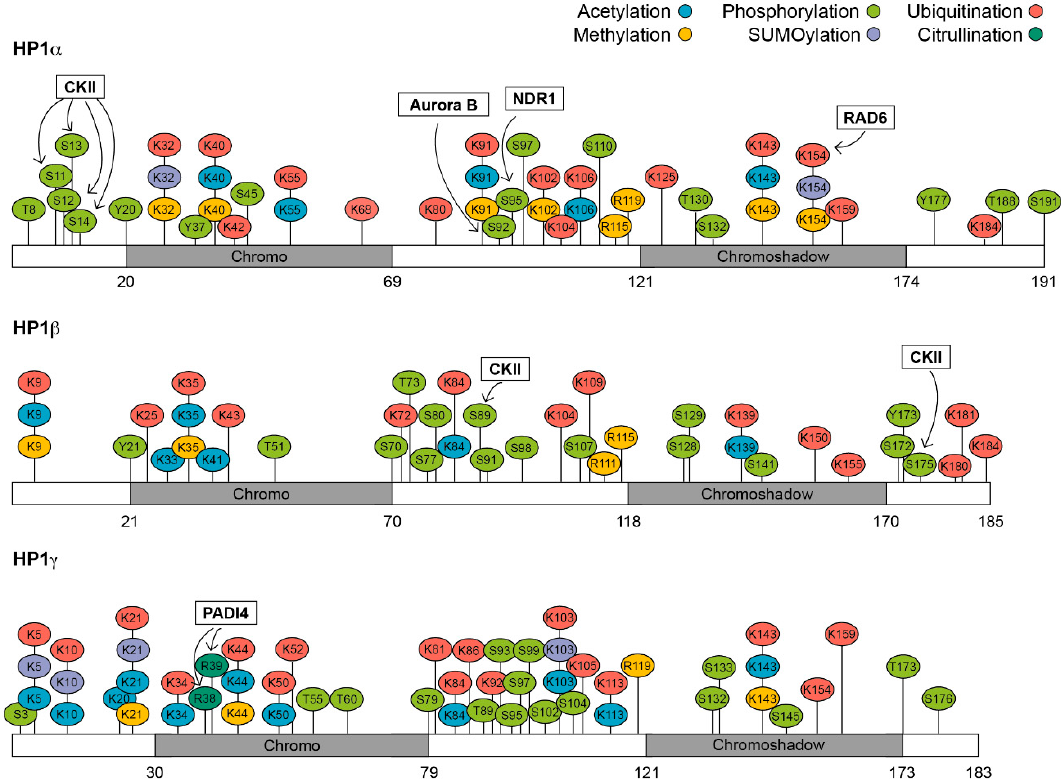
Figure 1. Heterochromatin Protein 1 (HP1) post-translational modifications. Acetylation (blue), methylation (yellow), phosphorylation (light green), SUMOylation (purple), ubiquitination (red) and citrullination (dark green) sites of HP1 α , HP1 β and HP1 γ are shown. Black boxes highlight the known enzymes that catalyse specific modifications: Casein Kinase II (CKII); Peptidylarginine deiminase type 4 (PADI4); nuclear Dbf2-related kinase (NDR1); radiation protein 6 (RAD6). Grey boxes represent the chromo- and chromoshadow domains of HP1; the number below indicate the amino acids.